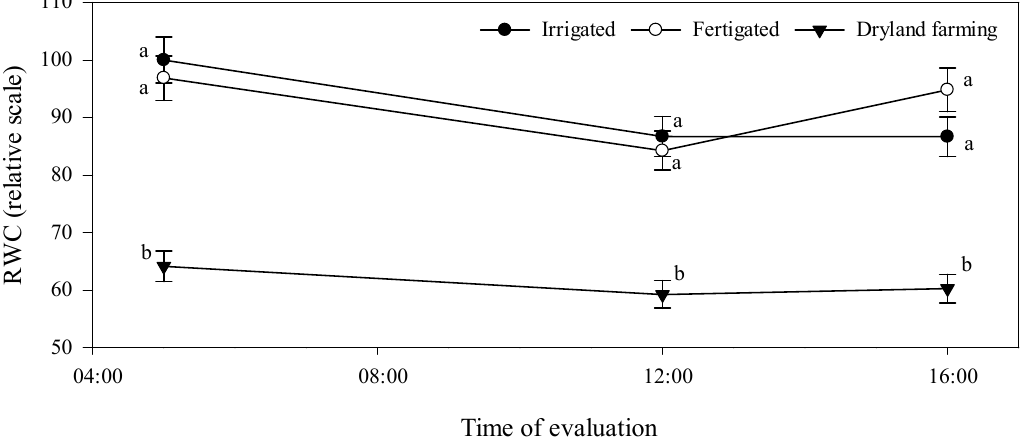
Figure 5. Relative water content (RWC) in the leaves of Amazonian Robustas at the time of the peak